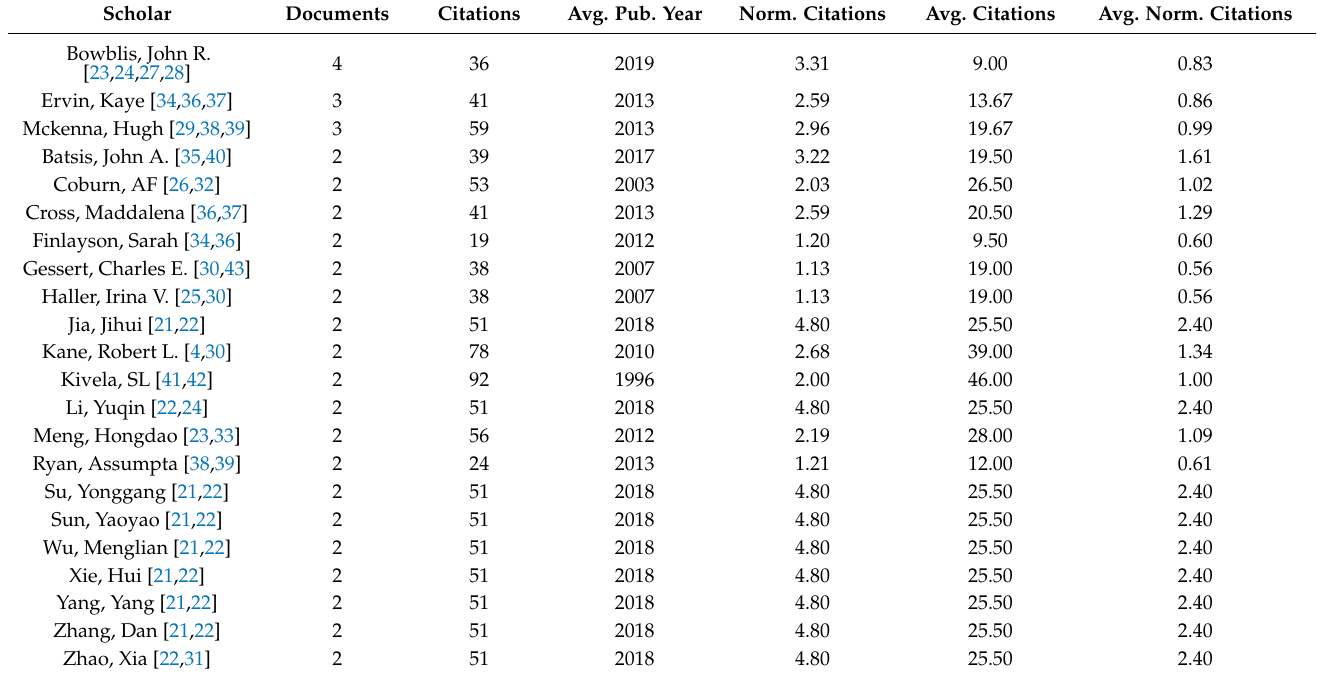
Table 2. Quantitative measurements of scholars in rural institutional elder care